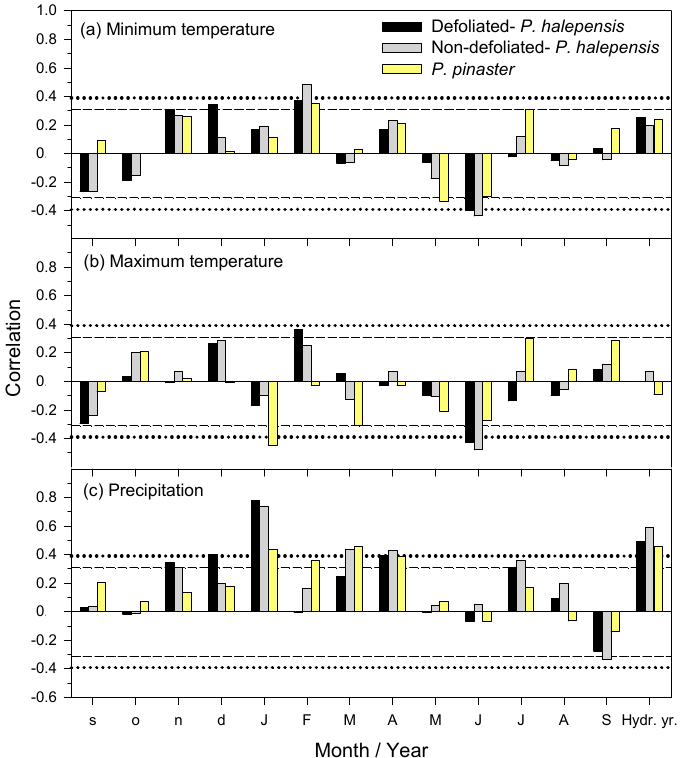
Figure 5 . Correlations calculated by relating monthly or annual climate variables (( a ) mean minimum temperatures, ( b ) mean maximum temperatures and ( c ) total precipitation) and series of ring-width indices of the three stand types (defoliated and non-defoliated P. halepensis ; P. pinaster ). Months abbreviated by lower- and uppercase letters correspond to the prior and current years, re-spectively. The dashed and dotted horizontal lines show the 0.05 and 0.01 significance levels, respectively.